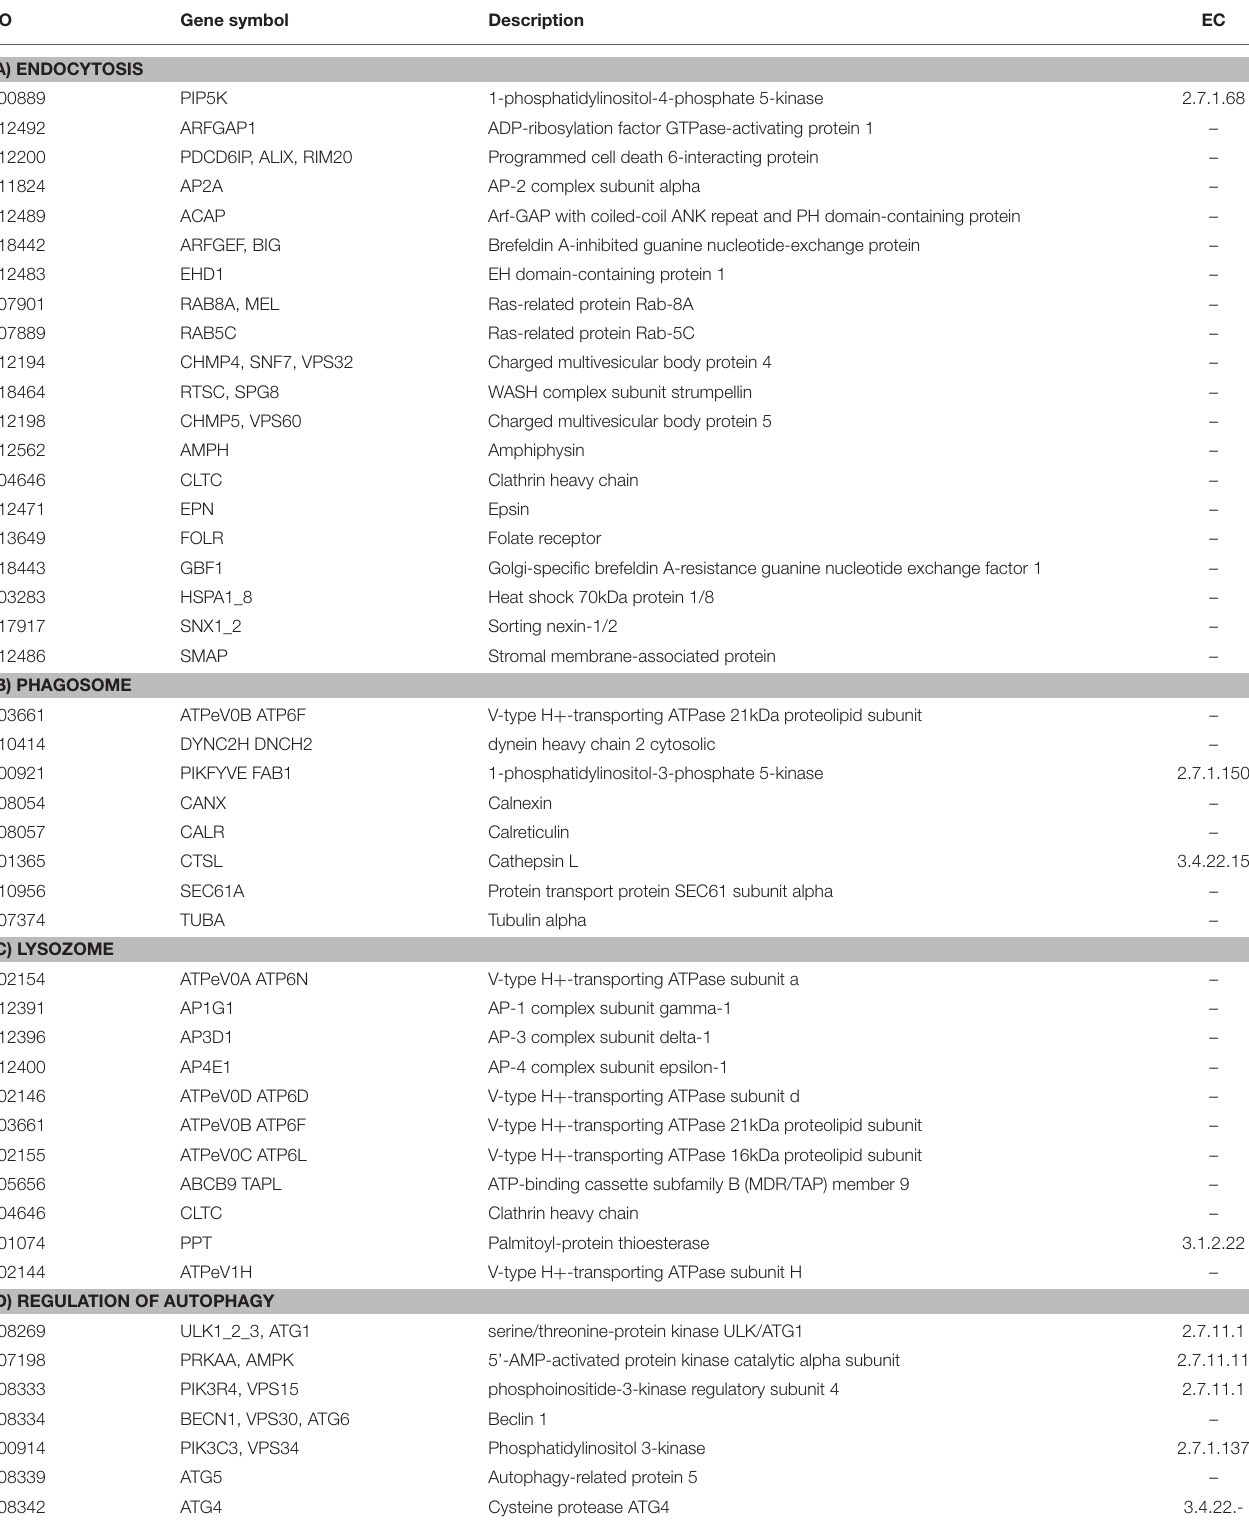
TABLE 2 | Functional annotation of transcripts encoding for enzymes associated with (A) Endocytosis, (B) Phagosome, (C) Lysozome, (D) Regulation of Autophagy, expressed in both M. polaris and P. tychotreta that as identified by the Kyoto Encyclopedia of Genes and Genomes.